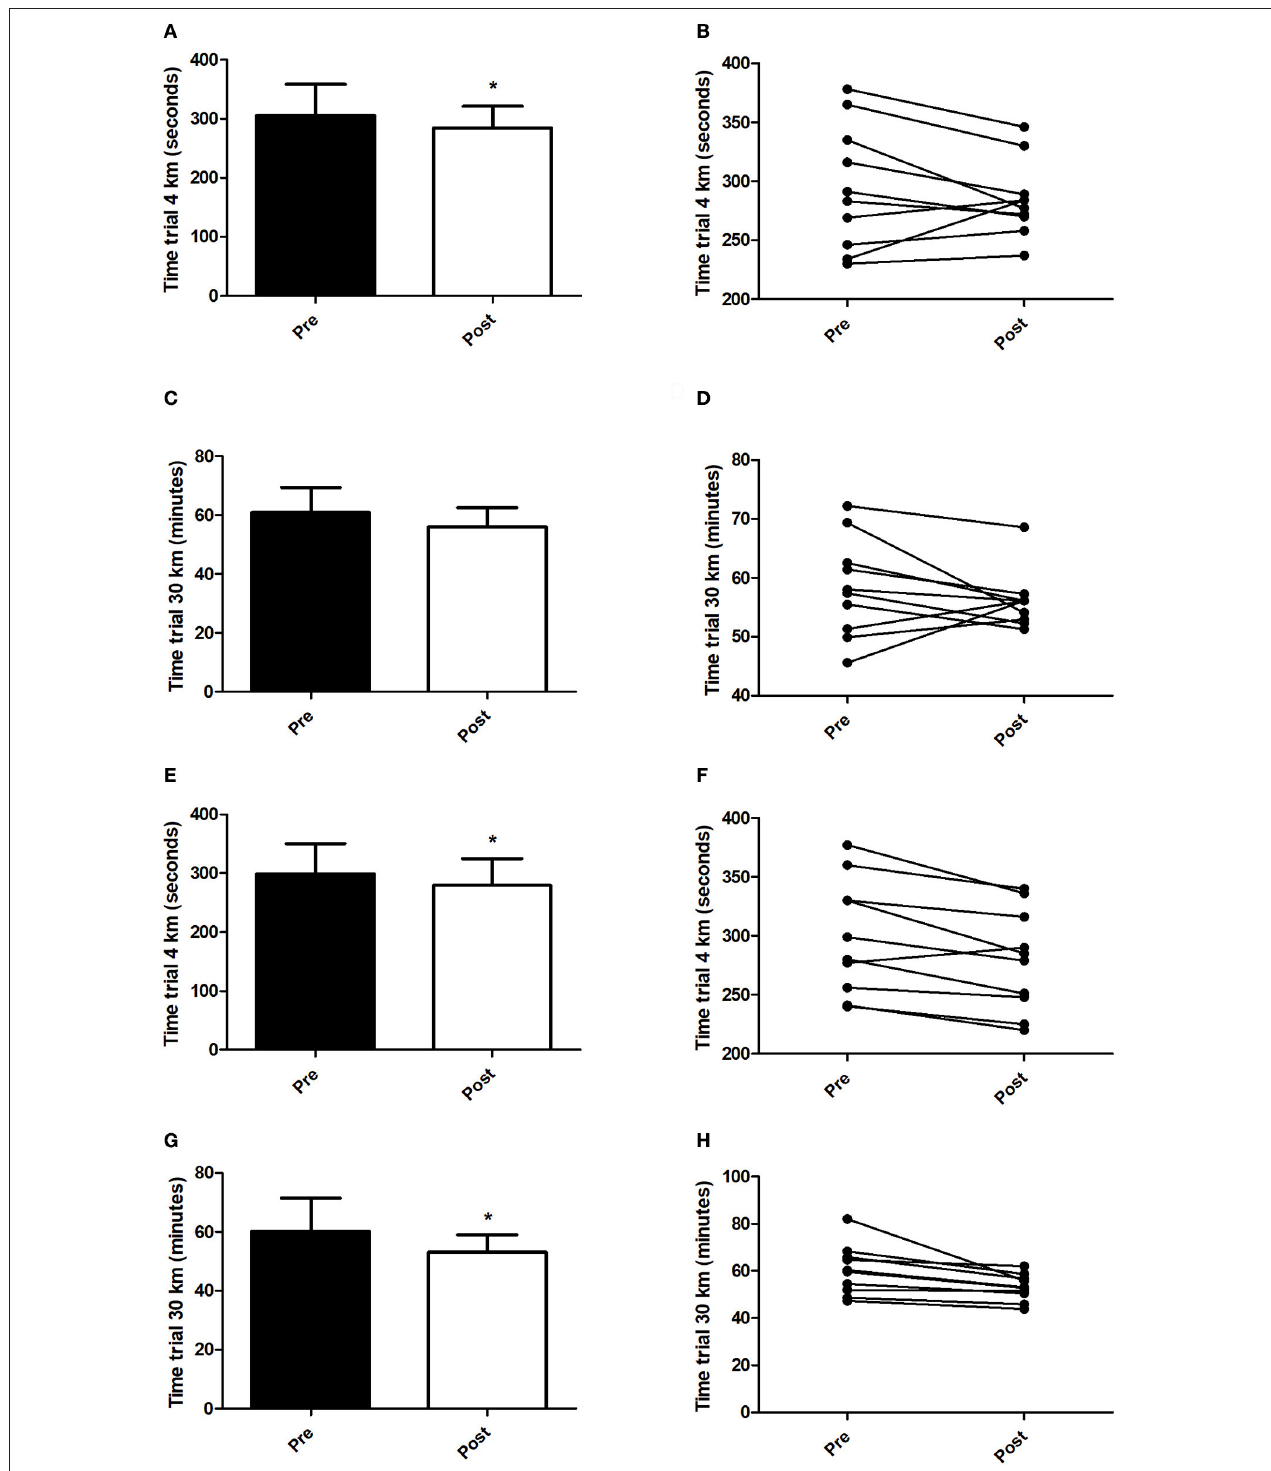
FIGURE 5 | Time trials. (A) Mean of minutes in 4km time trial test (HIIT + RS Condition), (B) Individual performance pre and post in 4km time trial test (HIIT + RS Condition), (C) Mean of minutes in 30km time trial test (HIIT + RS Condition), (D) Individual performance pre and post in 30km time trial test (HIIT + RS Condition), (E) Mean of minutes in 4km time trial test (HIIT + SD Condition), (F) Individual performance pre and post in 4km time trial test (HIIT + SD Condition), (G) Mean of minutes in 30km time trial test (HIIT + SD Condition), (H) Individual performance pre and post in 30km time trial test (HIIT + SD Condition). Student t -Test. Data presented as mean ± SD . *Different to pre